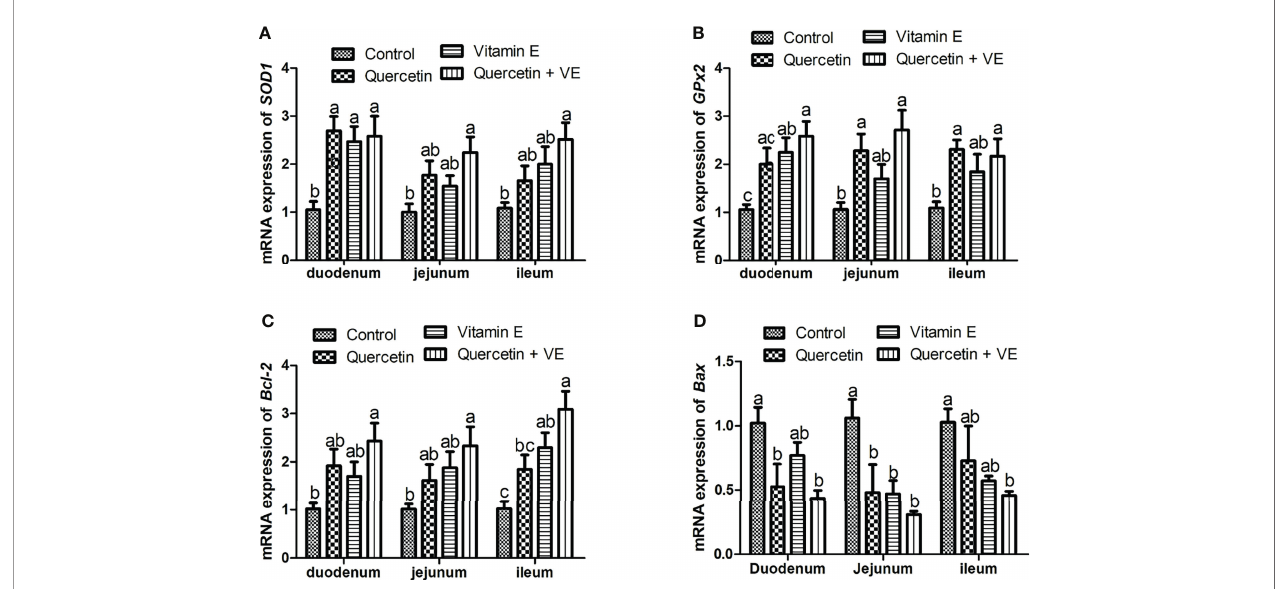
FIGURE 5 | Effects of dietary Q, VE, and Q + VE on the mRNA expressions of antioxidant and apoptosis related genes in the small intestine mucosa of aged breeder hens. mRNA expressions of antioxidant related genes (A, B) and apoptosis related genes (C, D) . Bars without the same letter differed signi fi cantly (P < 0.05).